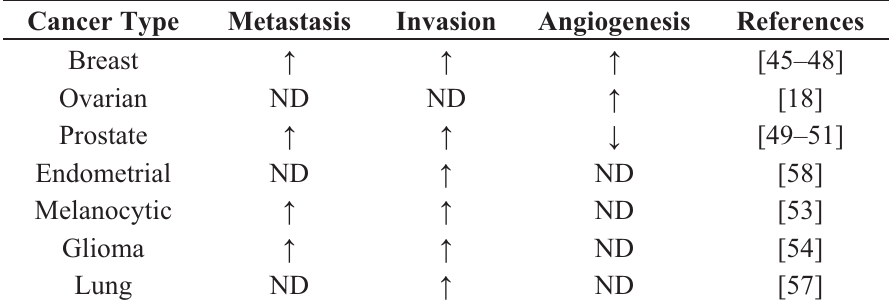
Table 1. Involvement of cathepsin D in the stages of tumor progression in different cancer